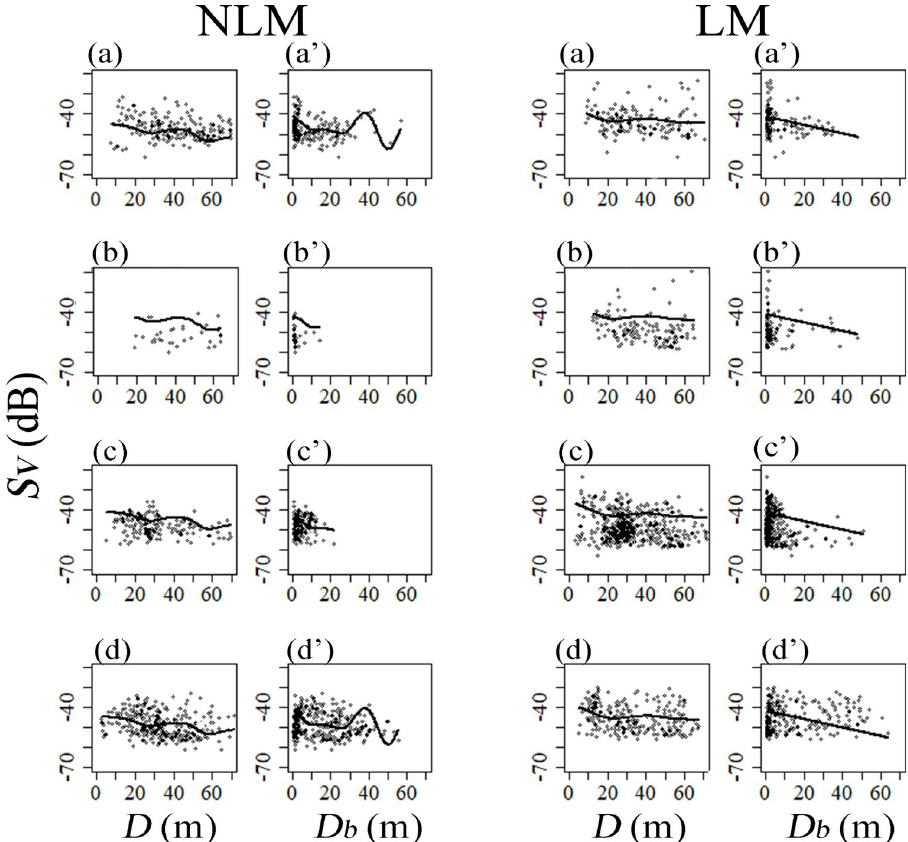
Fig 5. Seasonal variation of fish distribution in vertical structure expressed as the relationship between Sv (volume backscattering strength) and D (depth of fish school), Sv and D b (depth from bottom) based on GAM. The solid line shows the estimated line of fish density ( Sv ). The open circles show the measured value of Sv . The pictures of [a–d] show the data about D , and the pictures of [a’–d’] show the data about D Autumn, c and c’: Winter, d and d’: